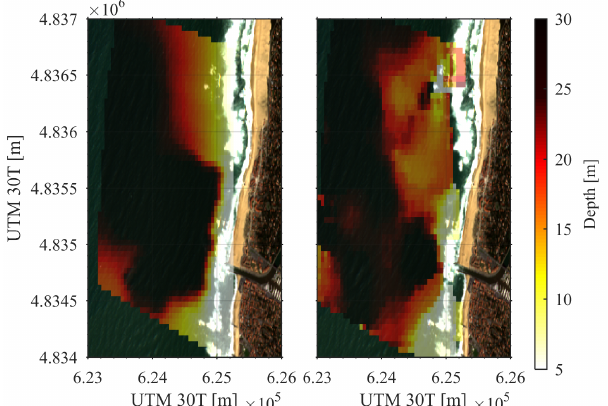
Figure 8. Measured ( left ) and Sentinel-2 estimated ( right ) water depths in the vicinity of the Capbreton harbour. The measured bathymetry is interpolated on the depth estimation locations. This highly complex bathymetry, in particular the contours of the deep-water channel and nearshore zone South of the harbour entrance show similarities.